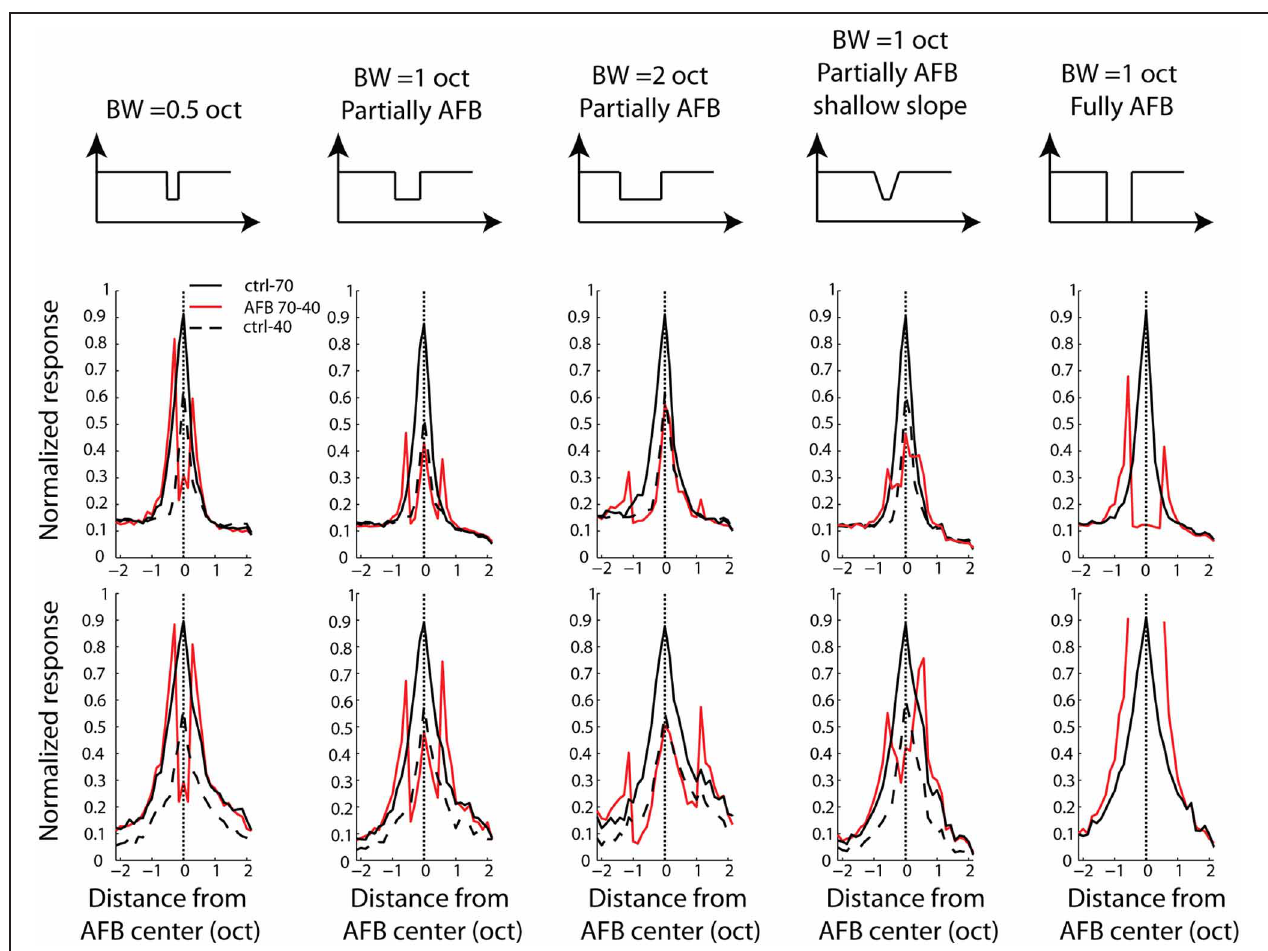
FIGURE 4 | Average frequency profile for all stimulus conditions, for one BF position relative to the AFB center (neural BF corresponding to the AFB center) for MUA (first row) and LFPs (second row). Frequency profiles are obtained by taking the maximal normalized firing rate (for MUA, or the minimal normalized amplitude for LFPs) between 10 and 40ms after stimulus onset. Each column corresponds to an AFB condition. Schematics illustrating the long-term spectrum of the acoustic conditions are shown at the top of the figure. First column: half-an-octave partially AFB. Second column: one-octave partially AFB.